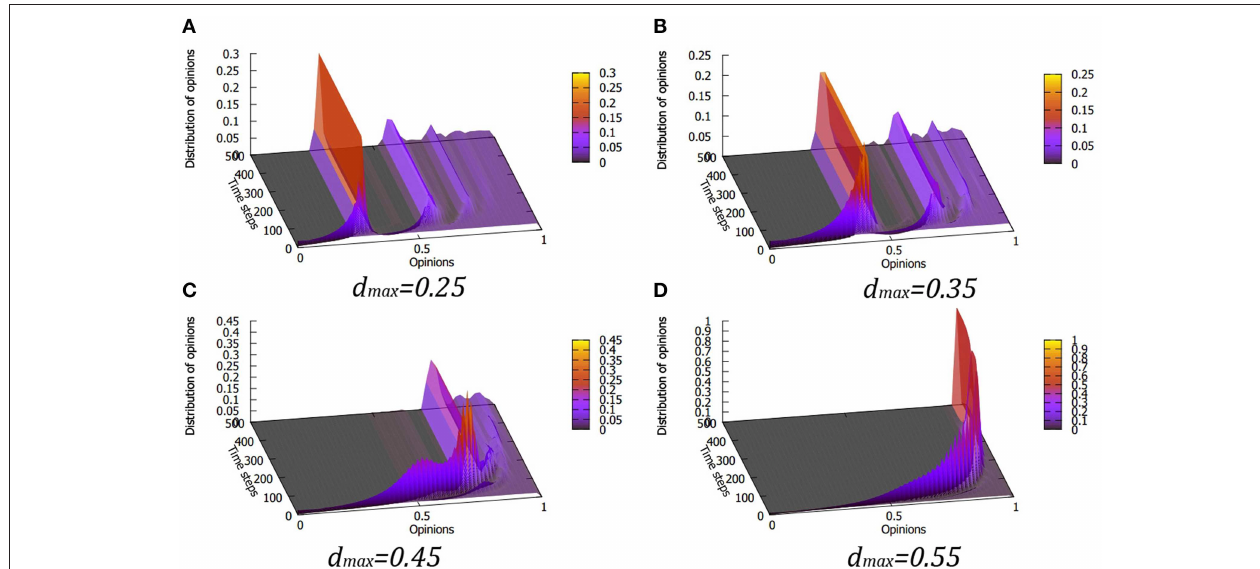
rearrangement at the high end of the opinion spectrum (B,C) . Above certain value of the tolerance of the open-minded agents (D) we observe fast transition to a single, extremist opinion. Note the differences in the vertical scales in the figure panels. The small oscillations visible especially in the early evolution in (C,D) are artifacts of the visualization.